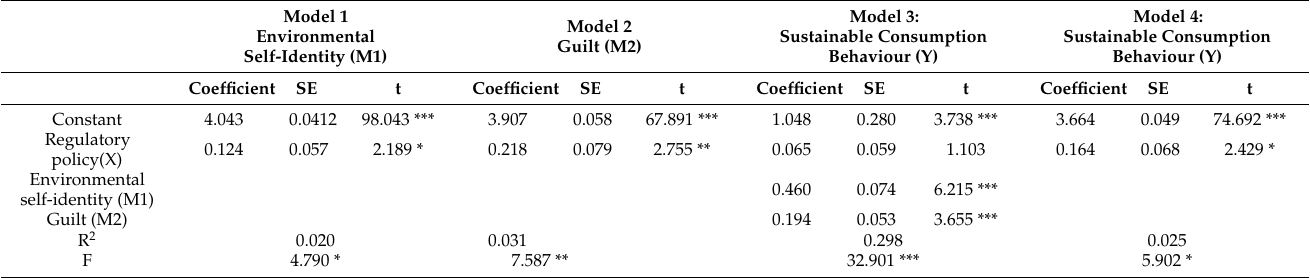
Table 4. Results for mediating effects.